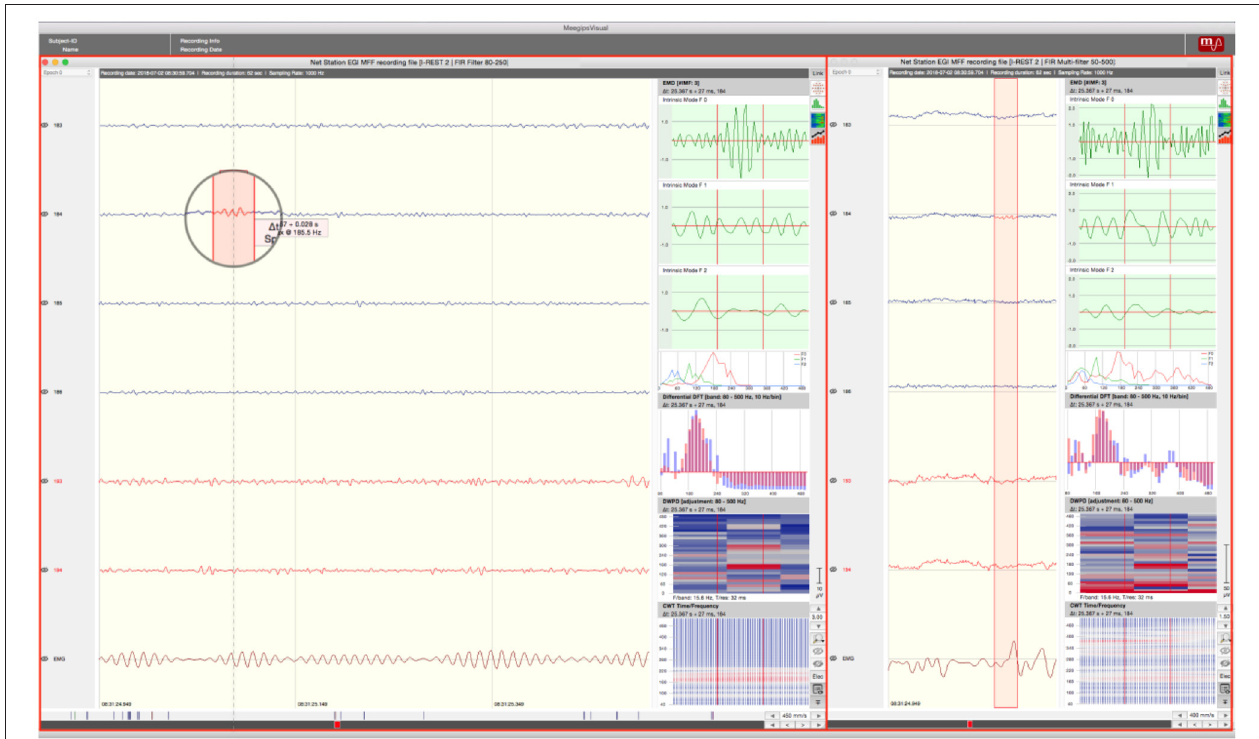
FIGURE 2 | Screen Arrangement MEEGIPS: Left side window depicts FIR filtered data (80–250Hz); Right side window depicts multifiltered data (50–500Hz). An overlap between marked event (red window in circle) and EMG activity can be seen. Therefore this event would have been marked as an artifact. Red marked channels were